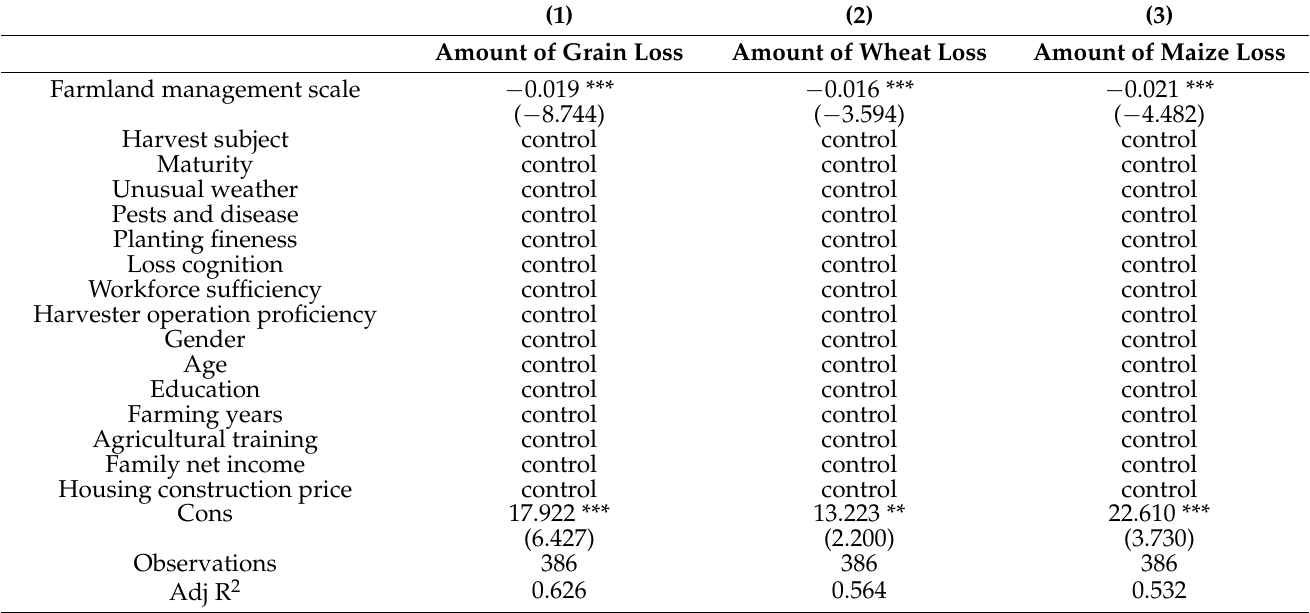
Table 5. Regression